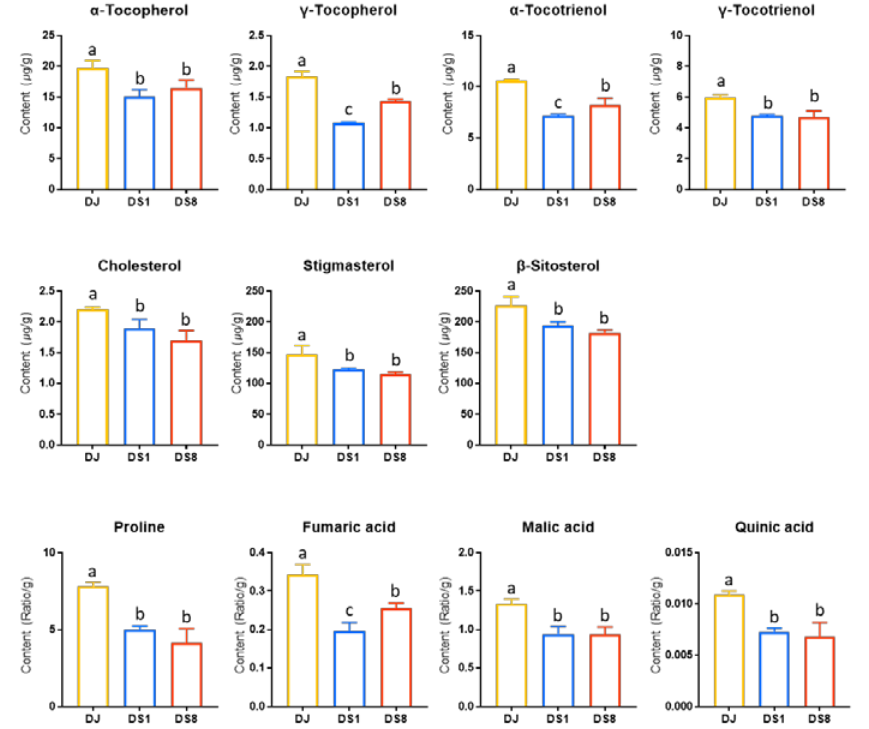
Figure 3. Contents of DJ, DS1, and DS8 rice metabolites with significant differences in ANOVA. Bar graphs with different letters (a, b, c) refer to the significant differences between the samples, as obtained by one-way ANOVA. Error bars represent standard deviations. Abbreviations: DJ, Oryza sativa L. cv. Dongjin; DS1, line 1 of transformed rice from DJ with PgDDS and CYP716A47 genes; DS8, line 8 of transformed rice from DJ with PgDDS and CYP716A47 genes.